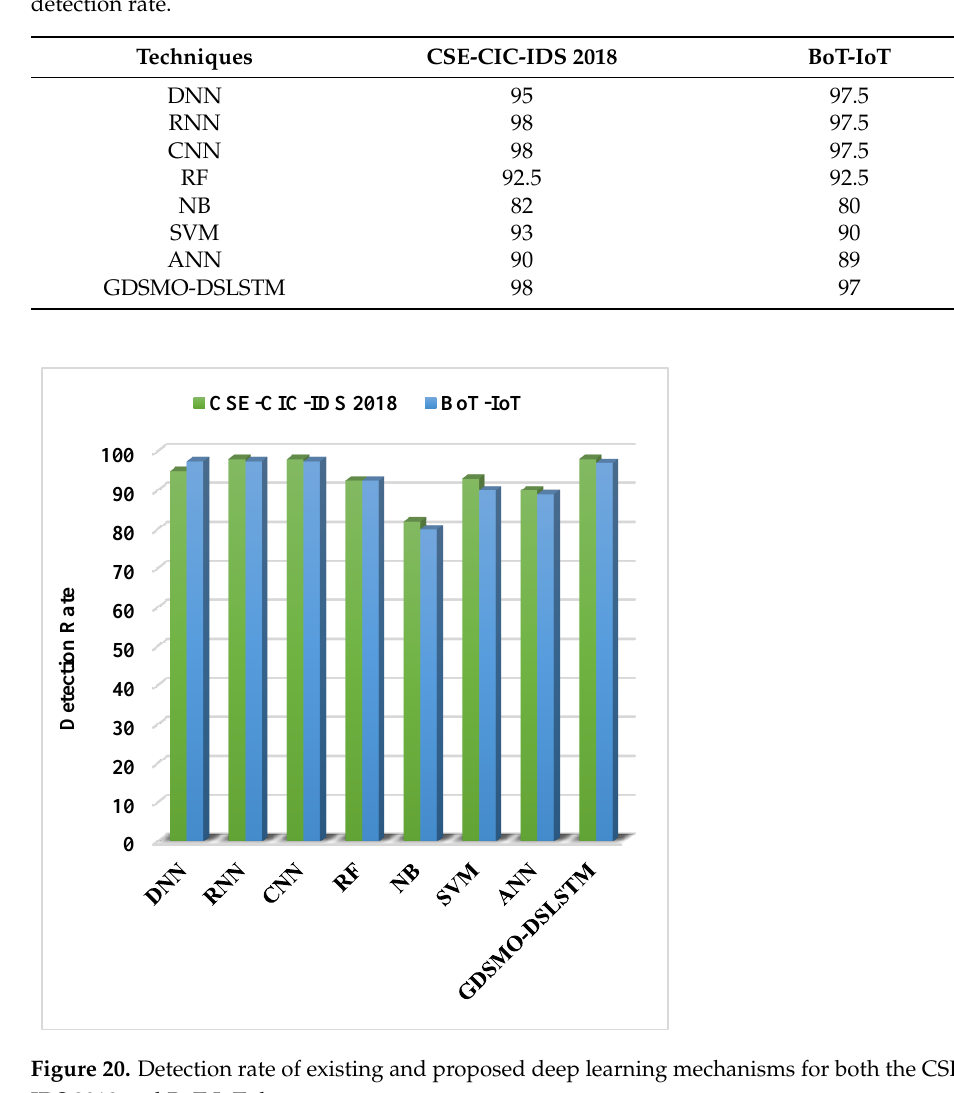
CSE-CIC-IDS 2018 and BoT-IoT datasets. IDS 2018 and BoT-IoT